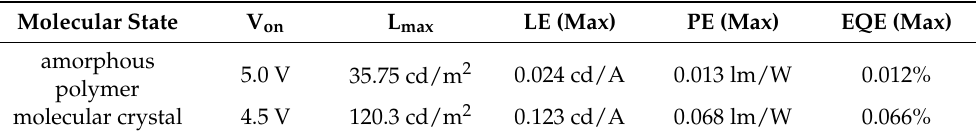
Figure 8. Electro-optical characteristics of OLED devices fabricated by spin coating and molecular ordering coating methods: ( a ) current density with log scale, ( b ) luminance, ( c ) luminous efficiency, ( d ) power efficiency, ( e ) quantum efficiency and ( f ) electroluminescence spectrum. Table 1. The measured electro-optical characteristics of OLED device fabricated by amorphous polymer and molecular